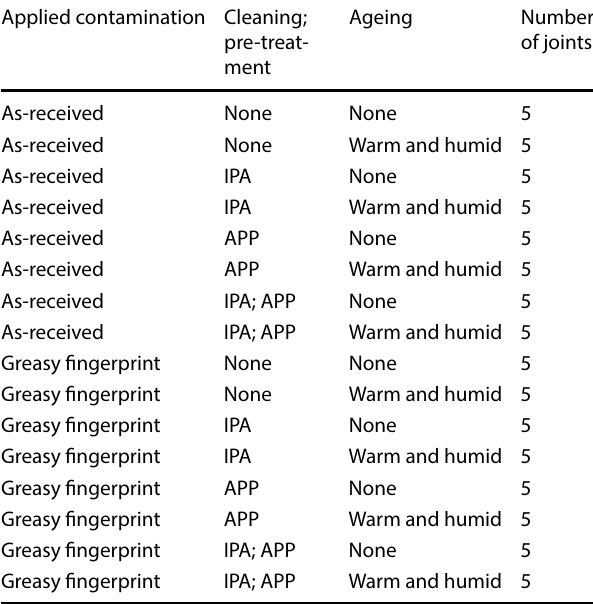
adhesive (IPA refers to isopropanol cleaning, and APP to a pre-treat- ment applying Atmospheric Pressure